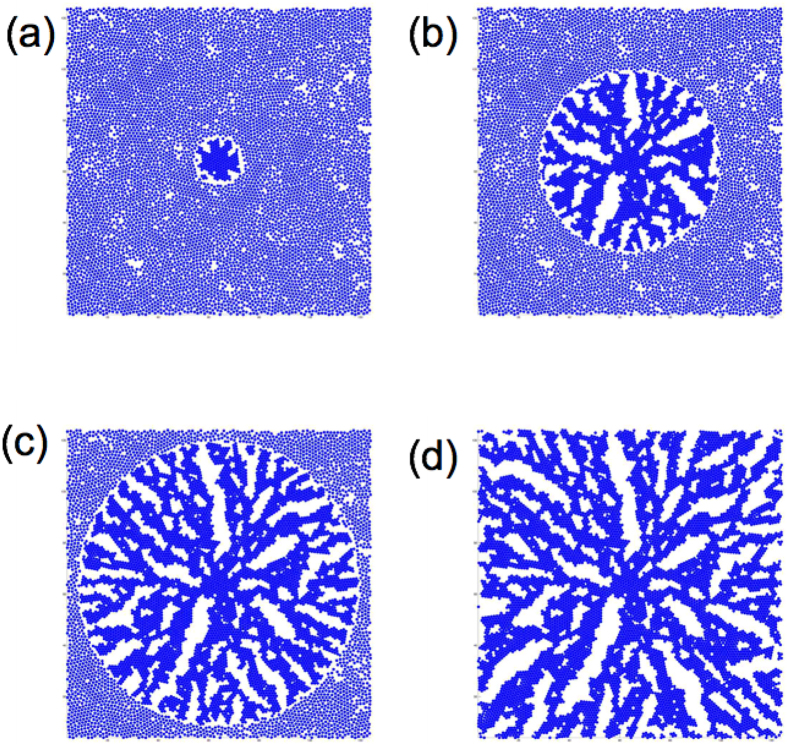
Time evolution of the aggregation patterns for ϕ = 0.78 and vtri = 10−3 at (a) t = 1.0 × 104, (b) 3.6 × 104, (c) 5.6 × 104 and (d) 8.3 × 104.